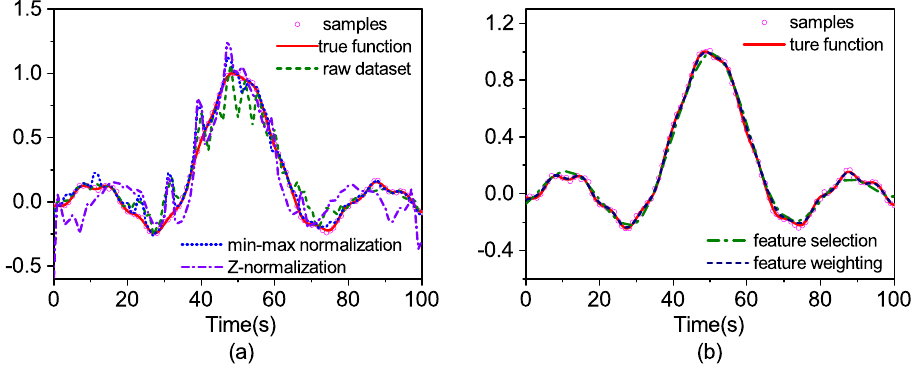
Figure 5. The prediction outputs for test set: ( a ) raw data and normalized data; ( b ) feature weighted and feature selected dataset.